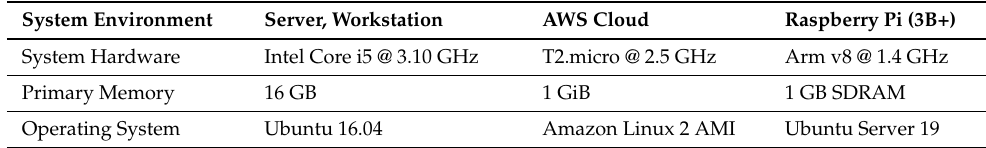
Table 2. Experimental setup.